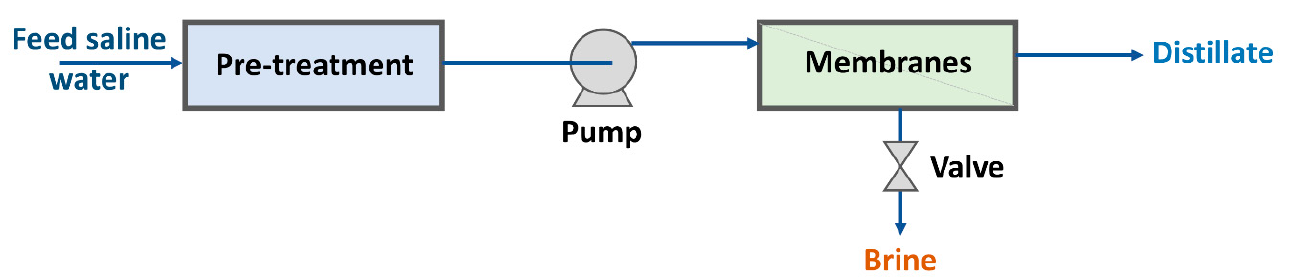
Figure 4. Schematic diagram of the reverse osmosis (RO) desalination system as proposed by Amidpour and Khoshgoftar Manesh [61].